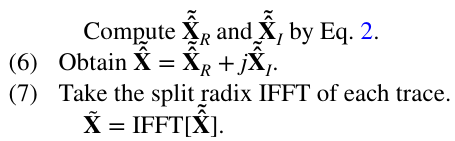
Fig. 2 Singular values decom- position of the frequency spectra. a The real part of the frequency spectra of the seismic data in Fig. 1. b The imaginary part of the frequency spectra of the seismic data in Fig. 1 c Singular values of the real part, with the blue line represent- ing whole singular values and the red line representing the selected singular values to be used in reconstruction. d Singu- lar values of the imaginary part, with the blue line representing whole singular values and the green line representing the selected singular values to be used in reconstruction. e The first eigenimage of the real